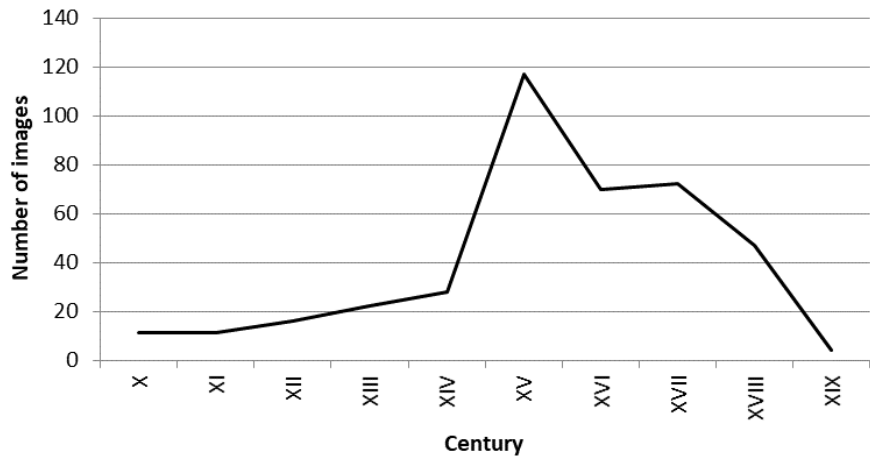
Figure 1. Number of images of Mary in the work of Trens by century (1946) Source: Authors’ elaboration based on Trens (1946).